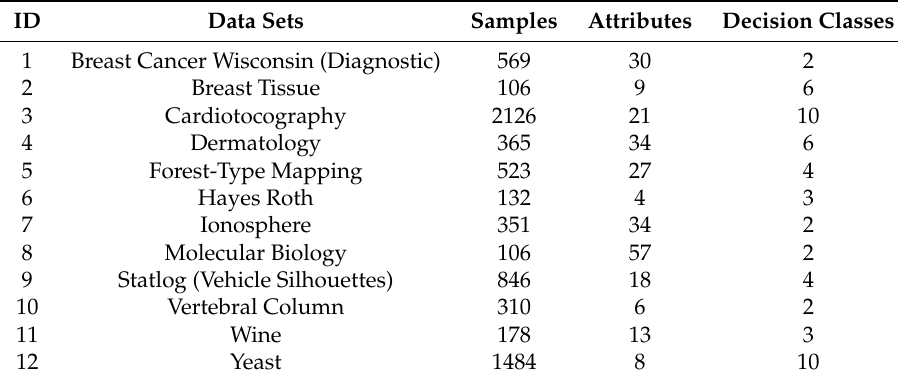
Table 2. Descriptions of